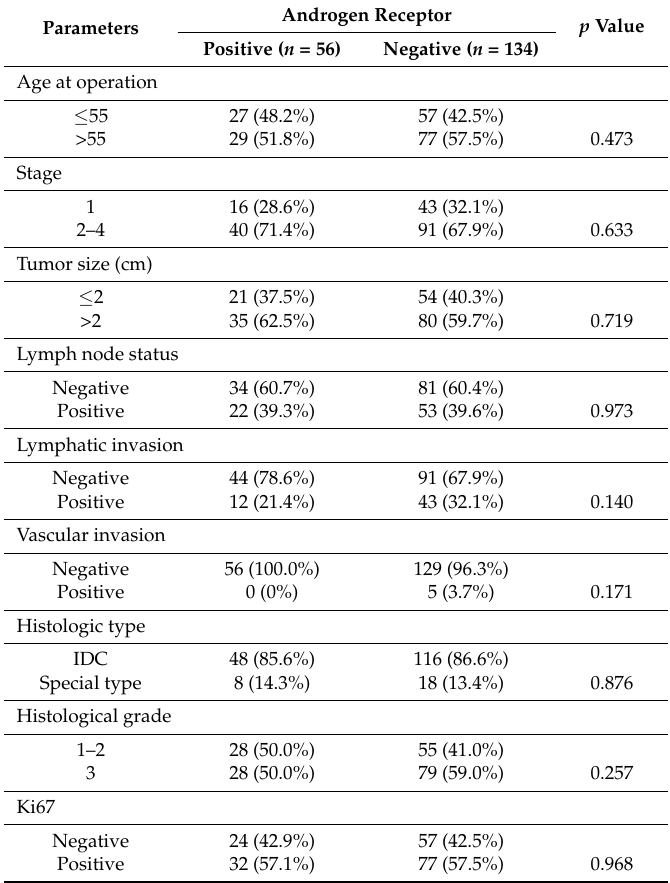
Table 1. Correlation between clinicopathological features and androgen receptor expression in 190 triple-negative breast cancer.